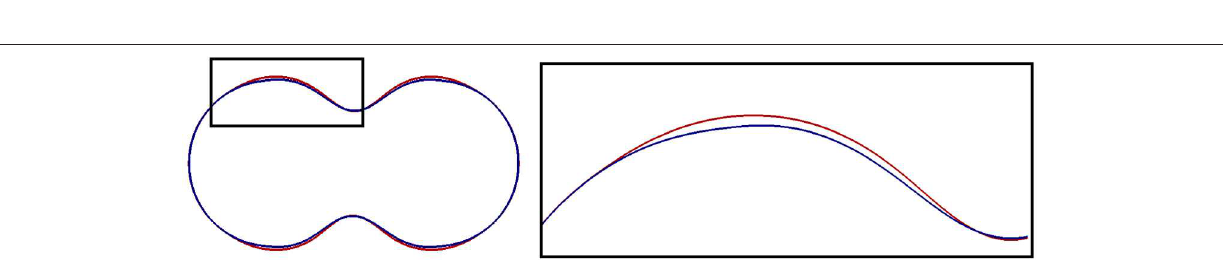
FIGURE 5 | Slices through the central axis of shapes obtained in simulations that we report on in section 5.3. A magnified image of the black box is presented on the right. The final shapes for two computations are displayed. One for the standard parameters in Table 1 (blue), and one with a smaller linker strength parameter, namely λ l 12 (red). In the latter case, the forces that keep the membrane attached to the cortex are smaller (see Equation (48), (49), λ l corresponds to k l in the = dimensional model). The area where the membrane has detached from the cortex is bigger, so the blebbing region is wider.